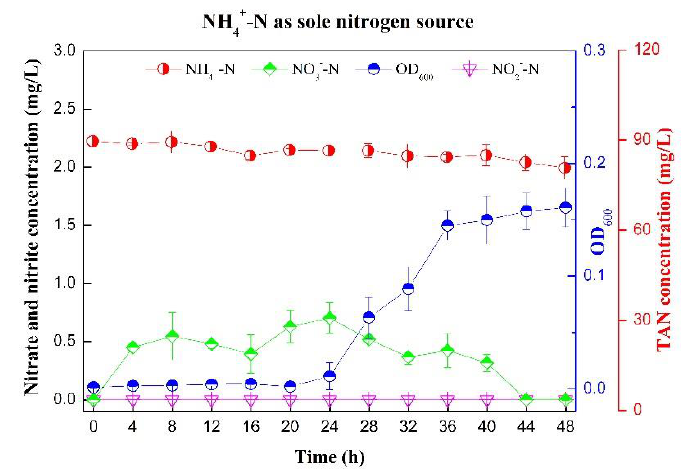
Figure 3. Aerobic ammonium-removal characteristics and cell growth of strain RAD-2 in heterotrophic nitrification media (HNM). Data shown are mean ± SD (error bars) from three replicates.